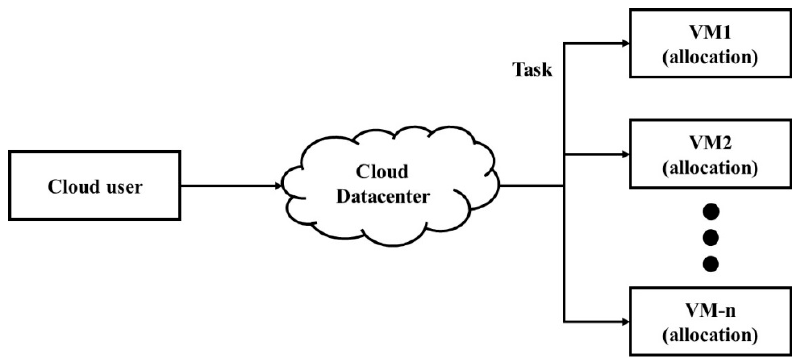
Figure 6. Virtual machine (VM) allocation in cloud data centers.